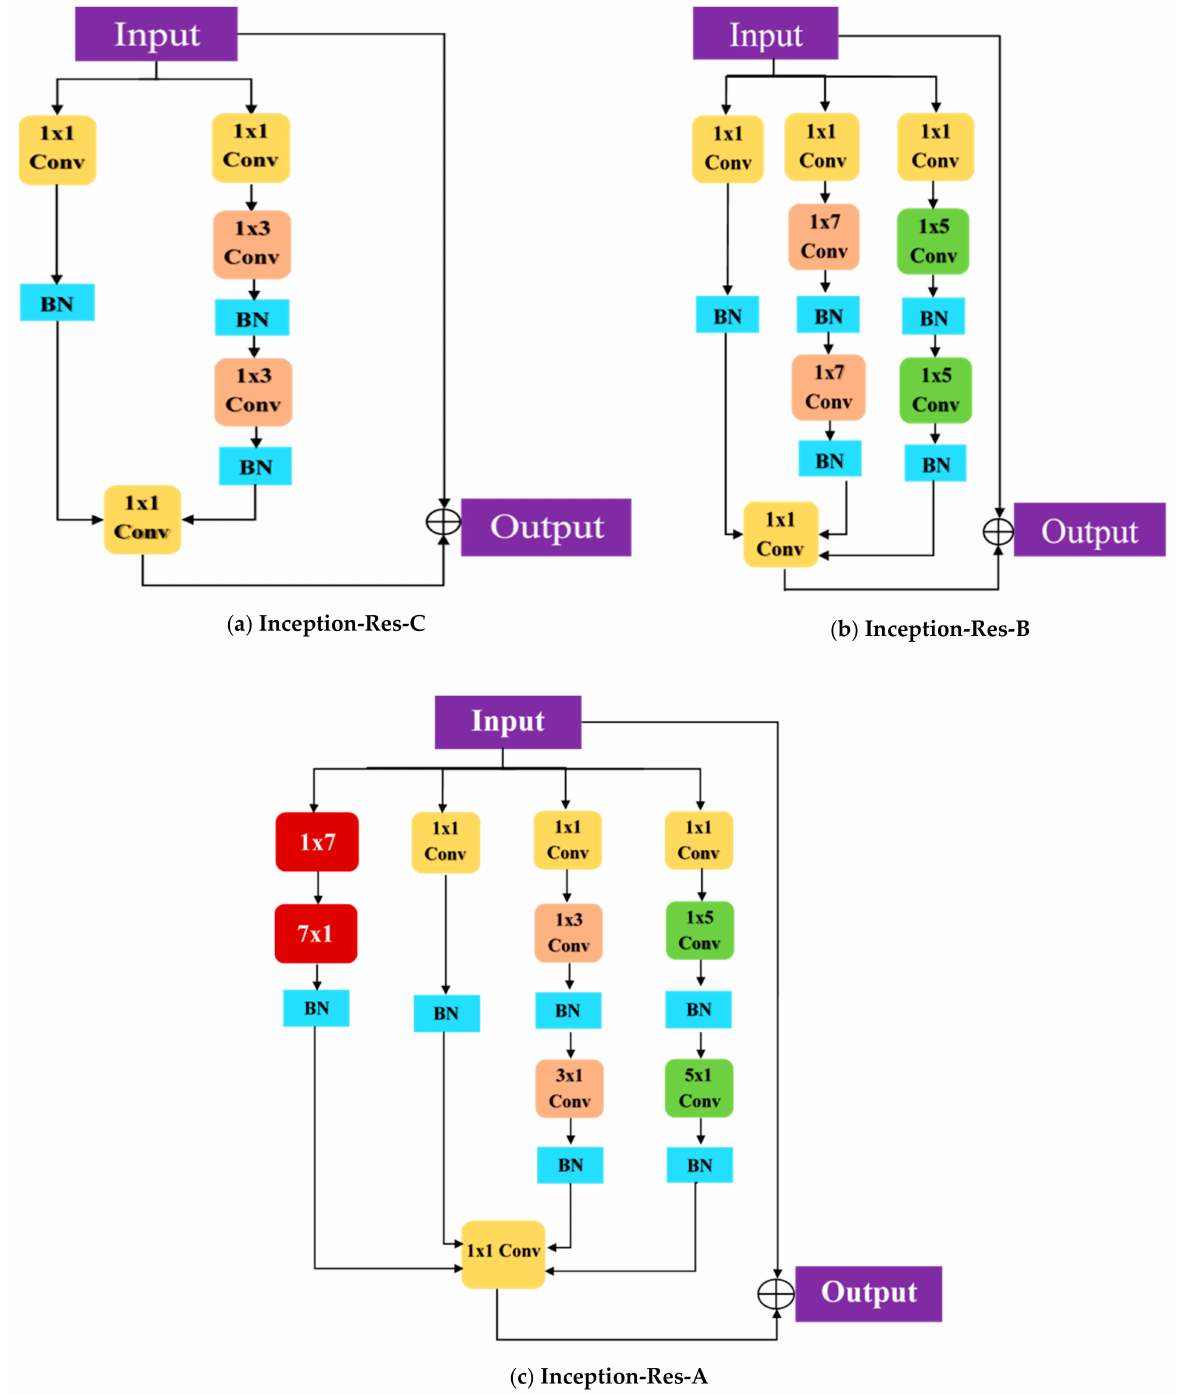
Figure 3. The Inception-ResNet blocks used in our proposed